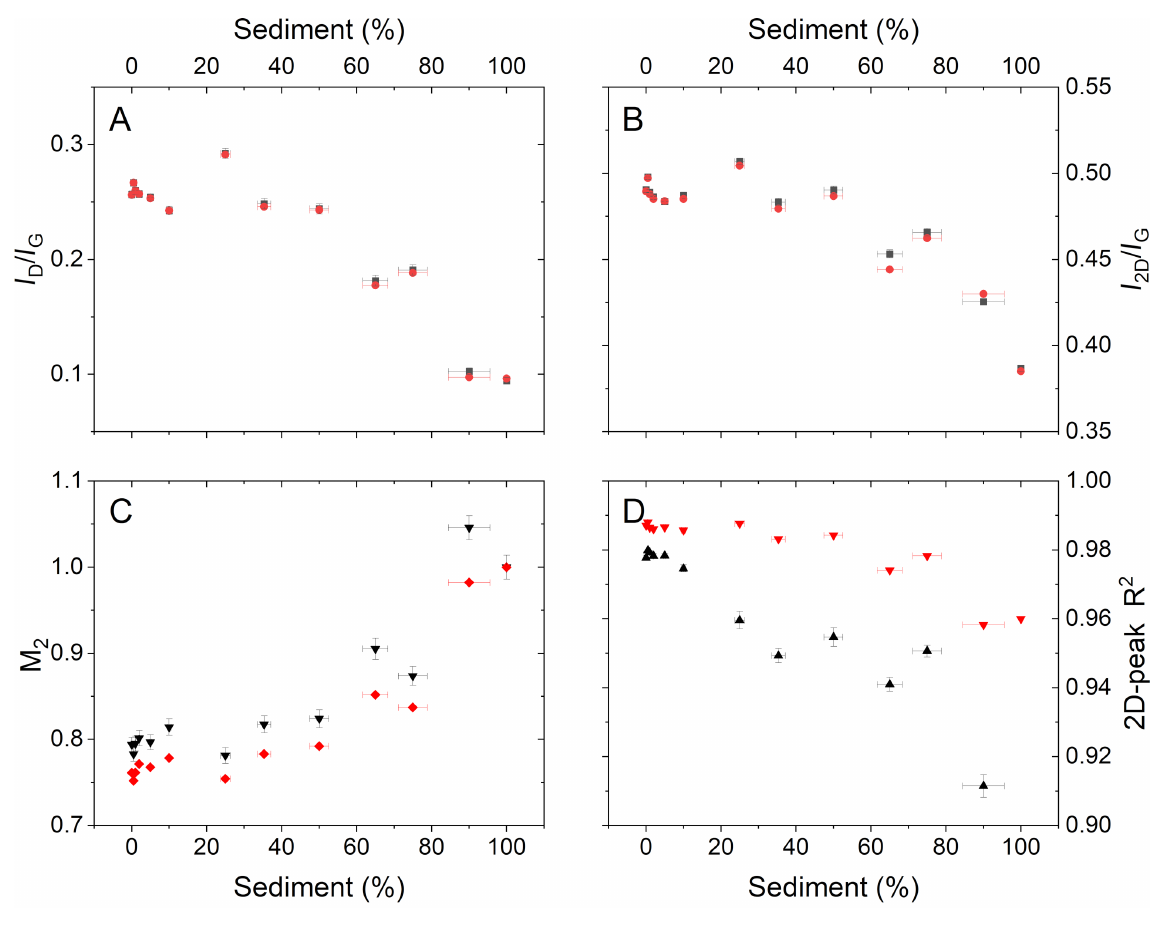
Figure 7: Values of the metrics at each sediment loading. (A) I D / I G intensity ratio; (B) I 2D / I G intensity ratio; (C) M 2 metric from Backes et al. [13]; (D) R 2 value from fitting the 2D peak to a single Voigt function. Results are shown from both the average spectra (red) and the mean value from the fitting of each spectrum in a map (black) showing the standard deviation as the error